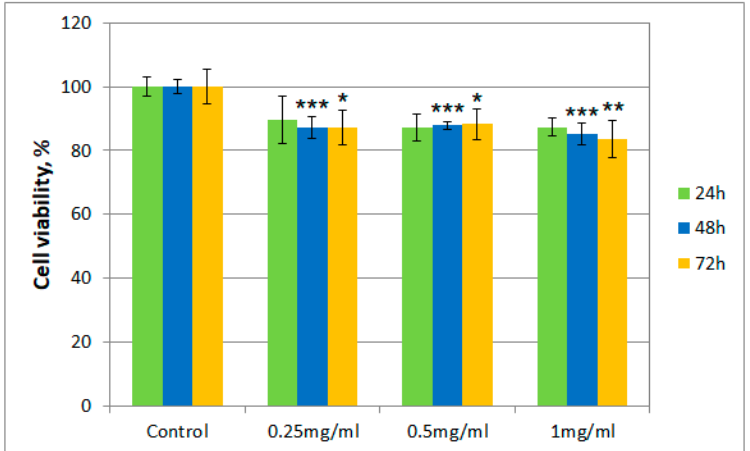
Table 3. Antioxidant activity of T. erecta total extract and fraction 4 (Fr 4).